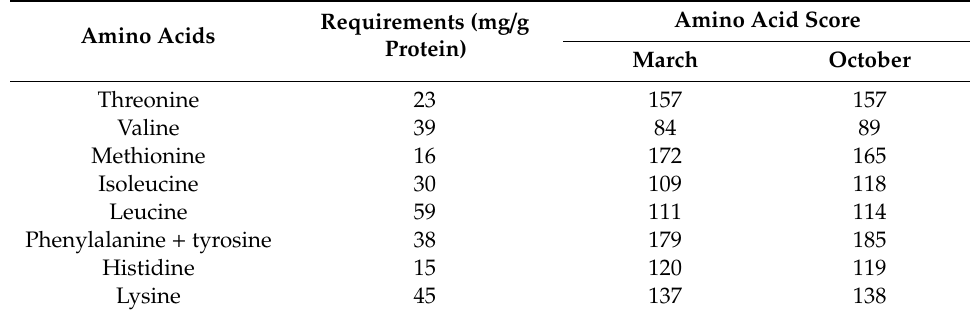
Table 5. Amino acid requirements for adults, according to WHO / FAO / UNU [33], and amino acid score (%) of the muscle proteins of C. maritae in both seasons (March and October). Amino Acid Score Requirements (mg / g Amino Acids Protein) March October